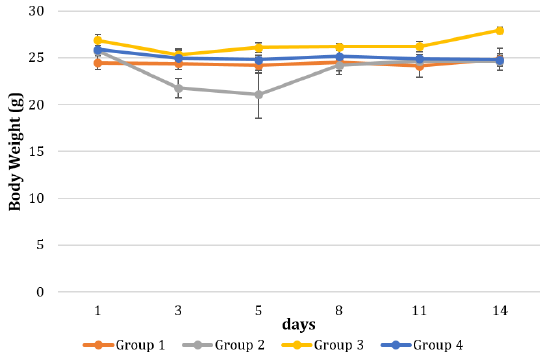
were within normal values (Table I).